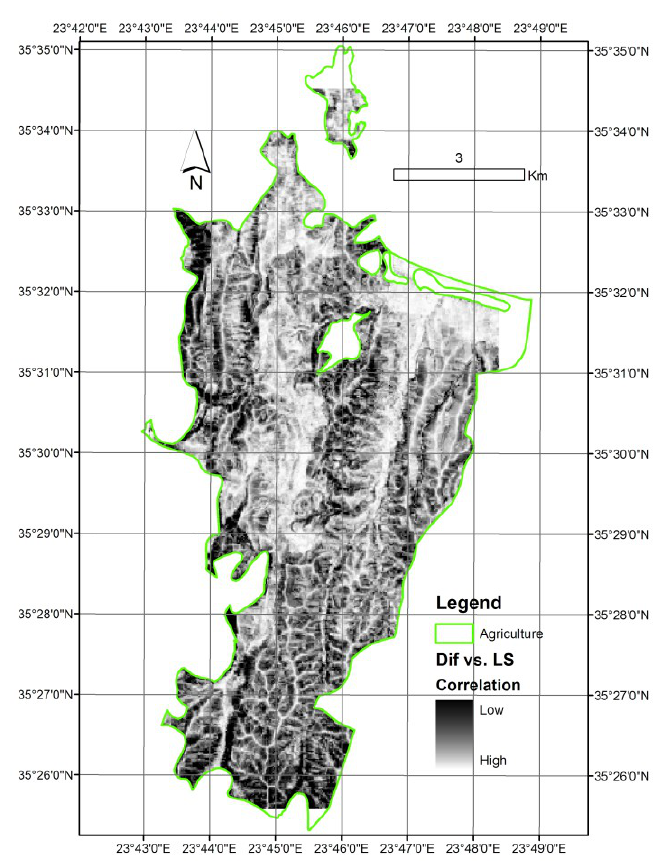
Figure 9. Spatial correlation of the terrain attributes (LS-layer) with the difference (NDif)